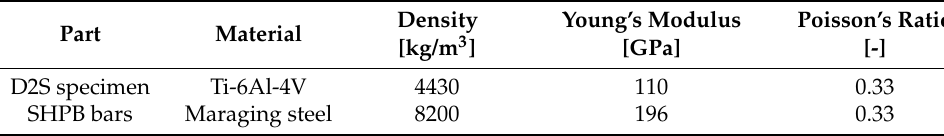
Table 2. Material parameters used in numerical